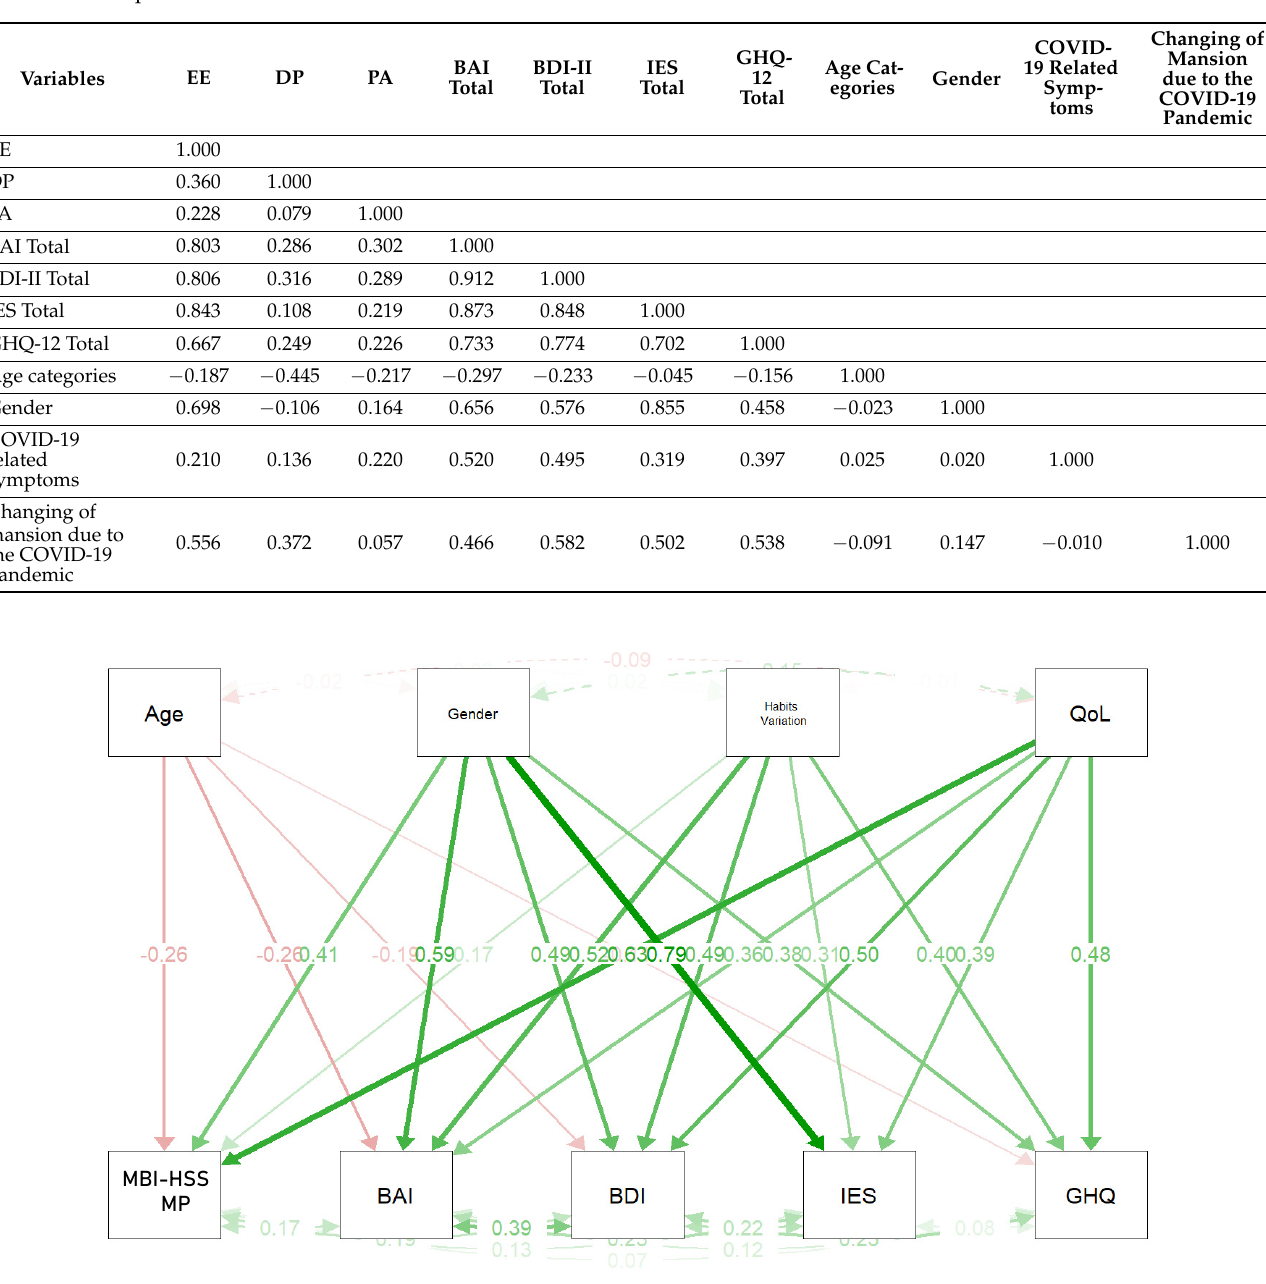
Figure 4. Mediation analysis with covariances (Age categories, Gender, Age categories, Gender, COVID-19 related symptoms, Changing of mansion due to the COVID-19 pandemic). Correlations among Medical Personnel (MBI-HSS MP), Beck Depression Inventory (BDI-II), Beck Anxiety Inventory (BAI), Impact of Event Scale (IES) and General Health Questionnaire 12 Items (GHQ-12).